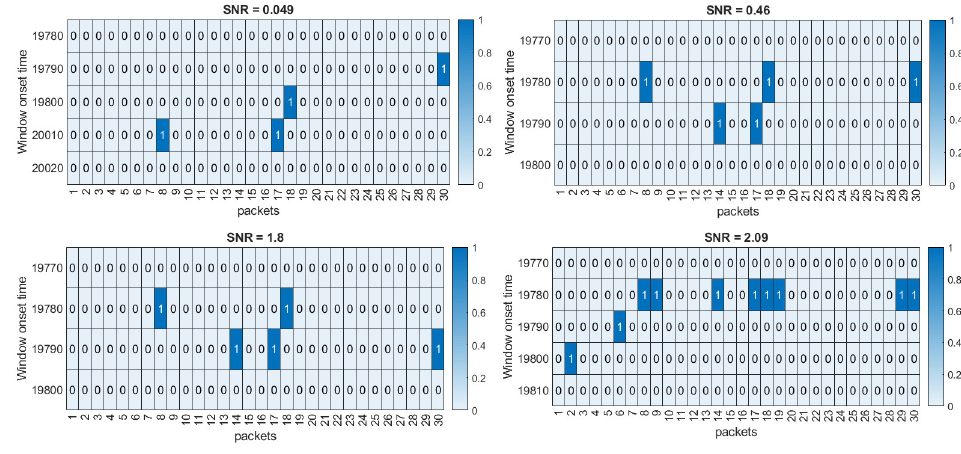
Fig 7. Selected packets for different SNR cases. Number of highlighted packets increases as the SNR